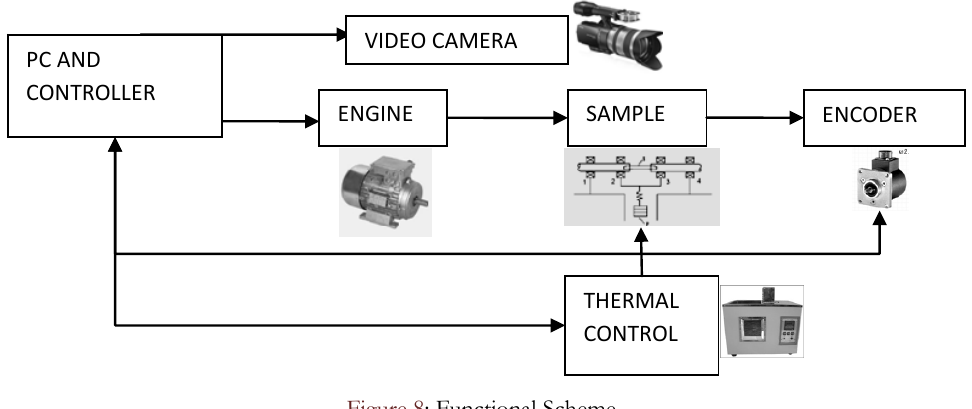
Figure 8: Functional